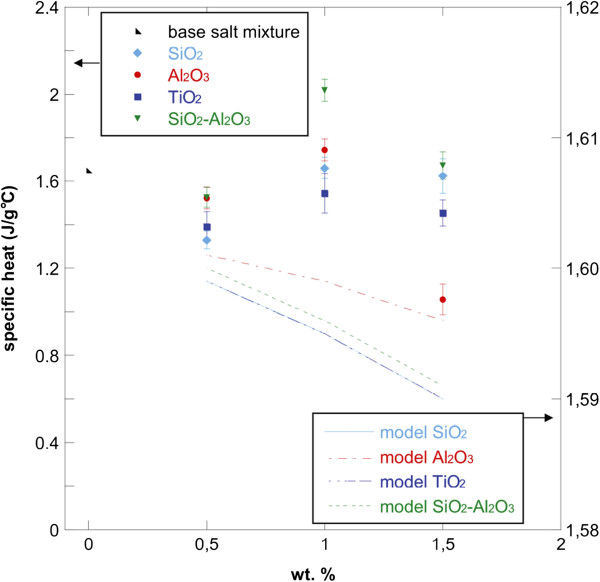
Specific heat values versus particle concentration for NaNO3-KNO3 binary salt mixture and nanofluids. Experimental data and model predictions.